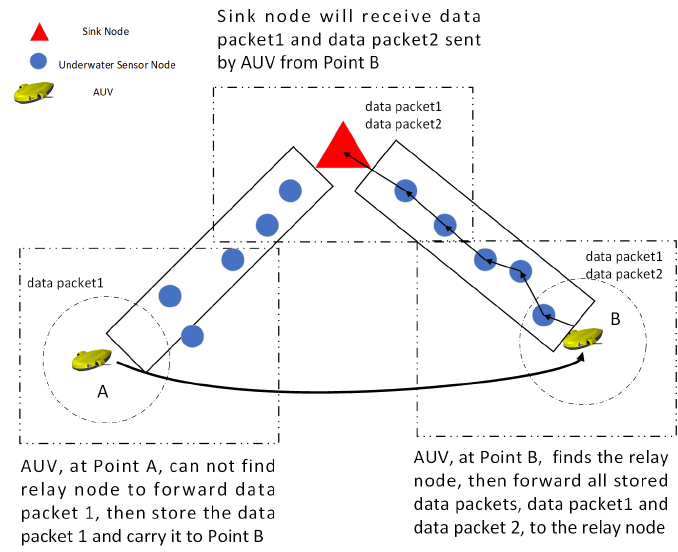
Figure 10. The schematic diagram of AUV “Store-Carry-Forward” mechanism.